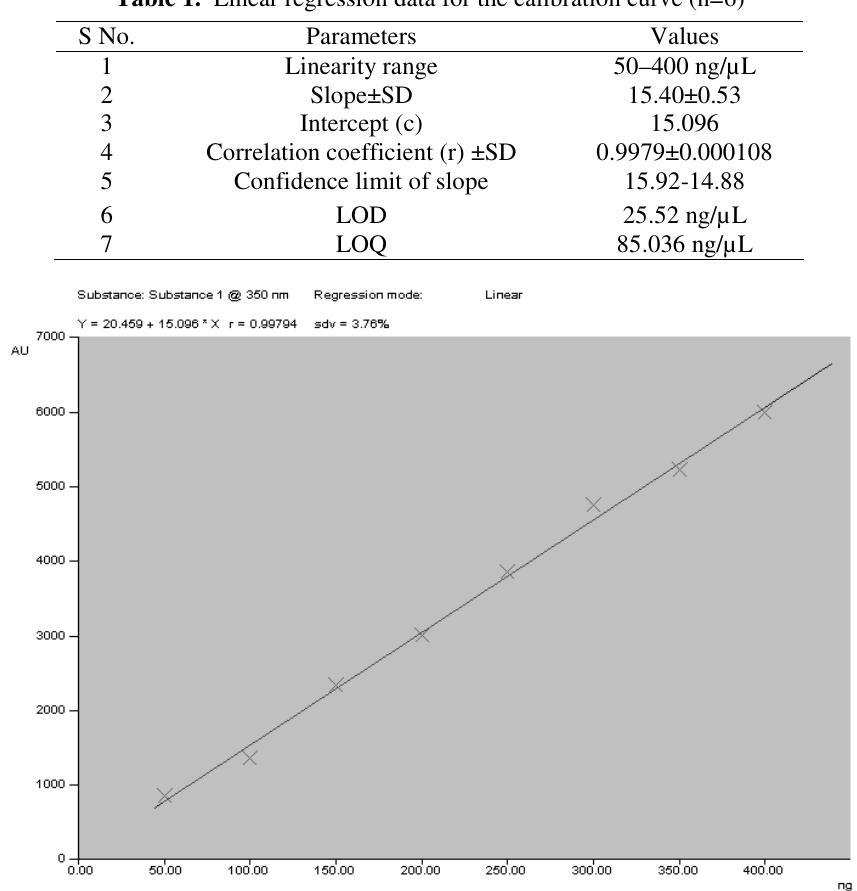
Figure 1. Calibration curve of standard rutin trihydrate